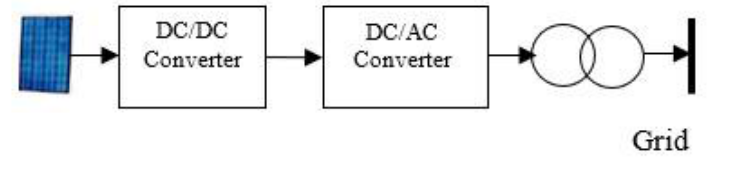
Figure 2. PV system configuration.